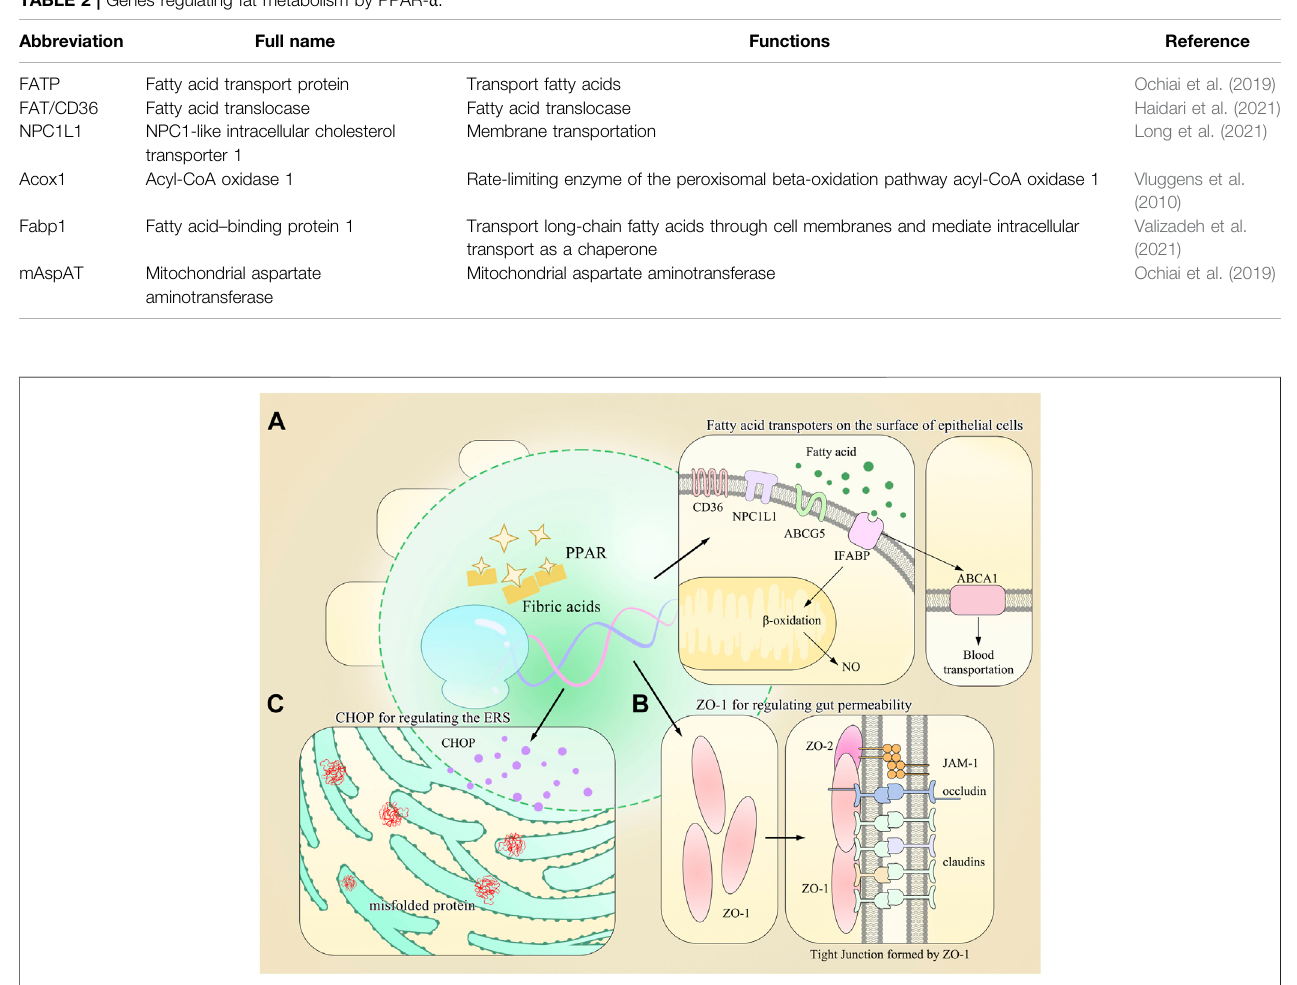
TABLE 2 | Genes regulating fat metabolism by PPAR- α .